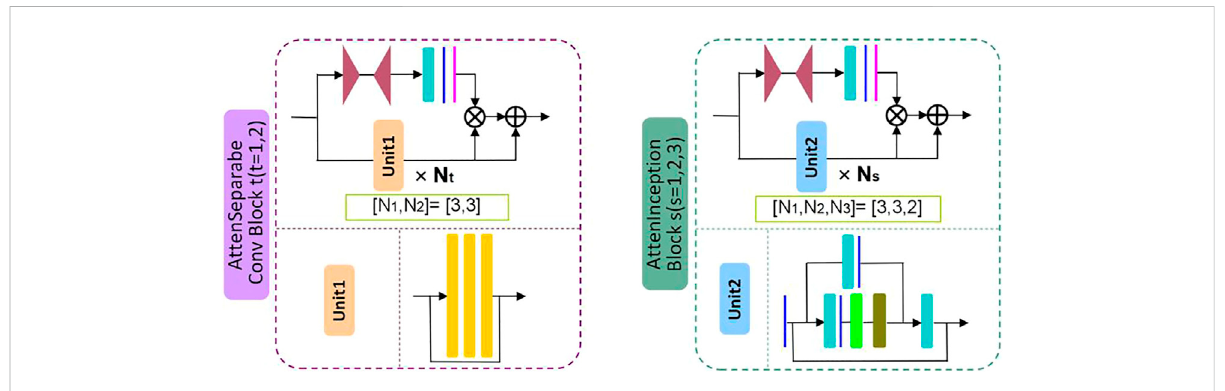
FIGURE 2 The proposed AttenSeparableConv Block and AttenInception